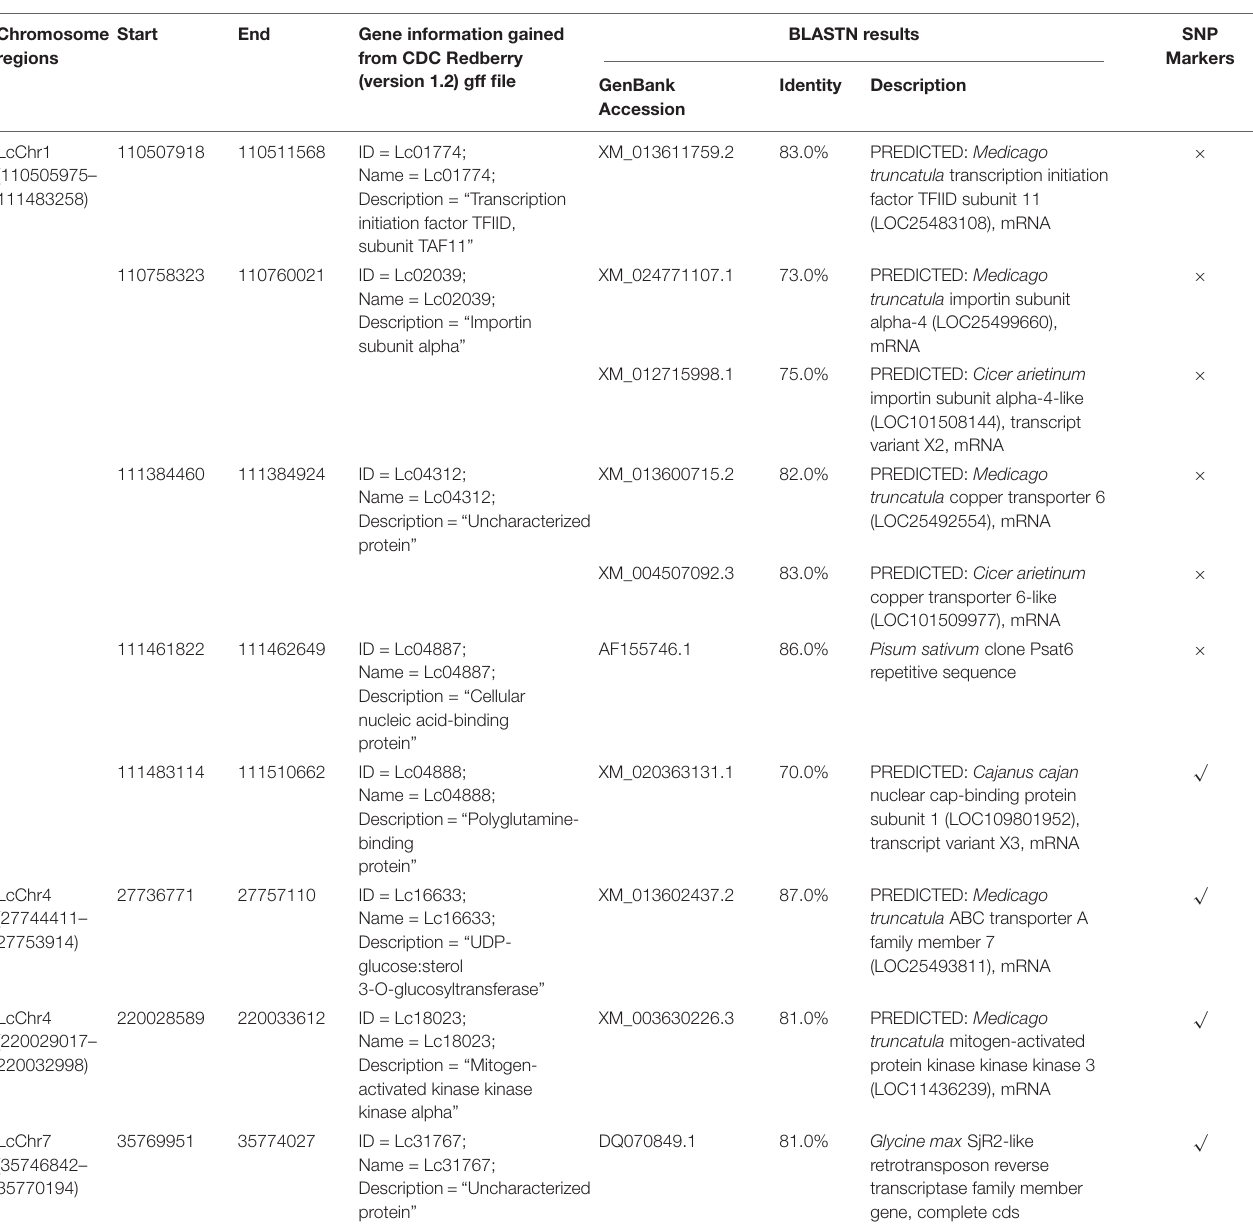
TABLE 5 | Genes identified for the major chromosome regions. Chromosome